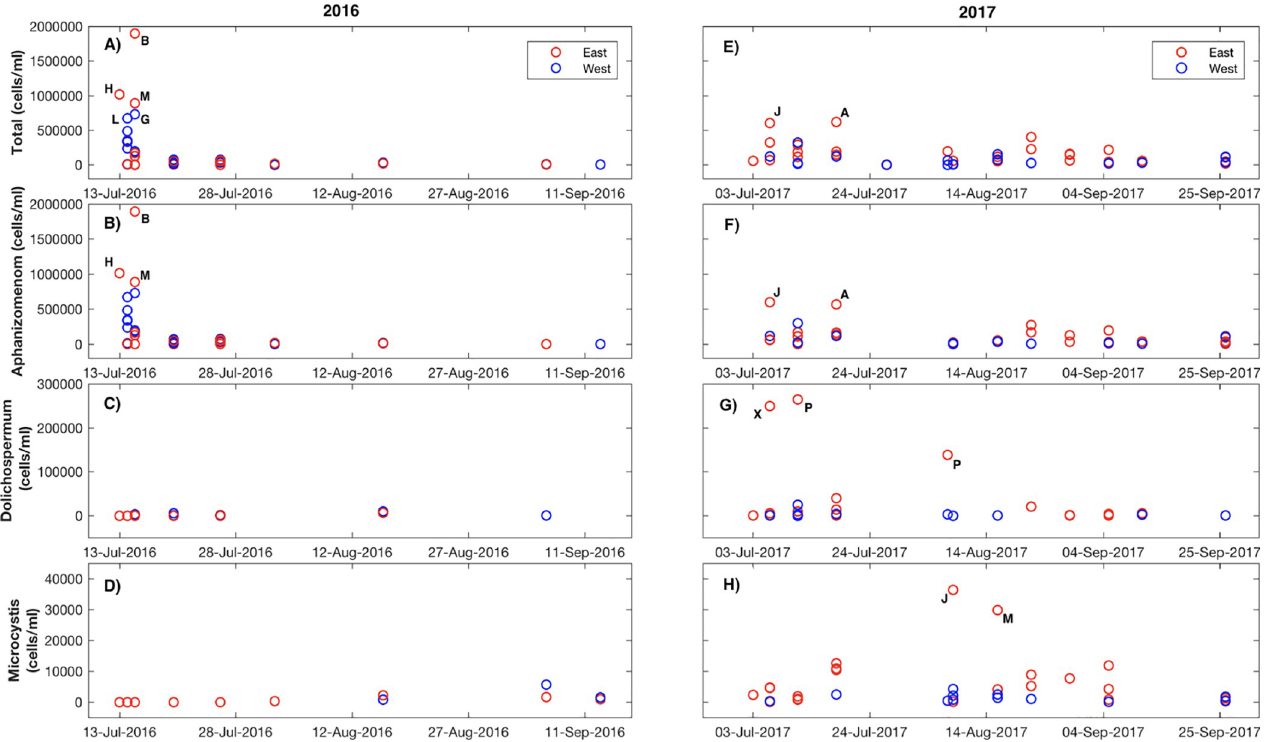
Fig 6. The abundance of total cyanobacteria in Utah Lake during summer 2016 and 2017. (A, E), Aphanizomenon flos - aquae (B, F), Dolichospermum flosaquae species (C, G), and Microcystis aeruginosa (D, H) cell counts for the summer of 2016 ( n = 46) and 2017 ( n = 52) across Utah Lake. Red circles and blue circles represent cell counts via semi-automated imaging flow cytometry from individual samples from the east and west side of the lake. Site labels correspond to locations shown in S2